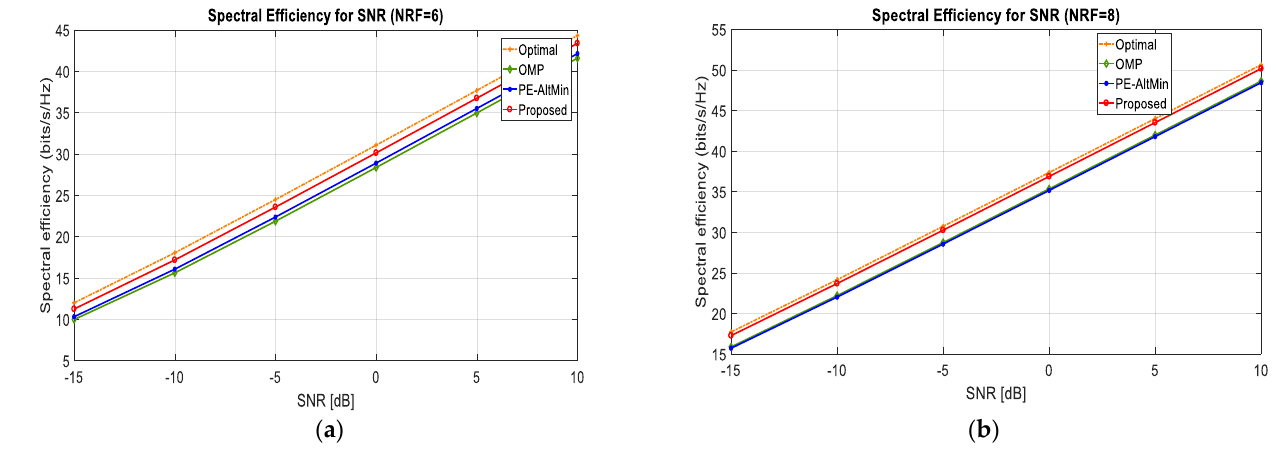
Figure 5. ( a ) Spectral efficiency at 𝑁 𝑇𝑅𝐹 = 6. ( b ) Spectral efficiency at 𝑁 𝑇𝑅𝐹 = 8. Comparison of Proposed Model with Existing Techniques